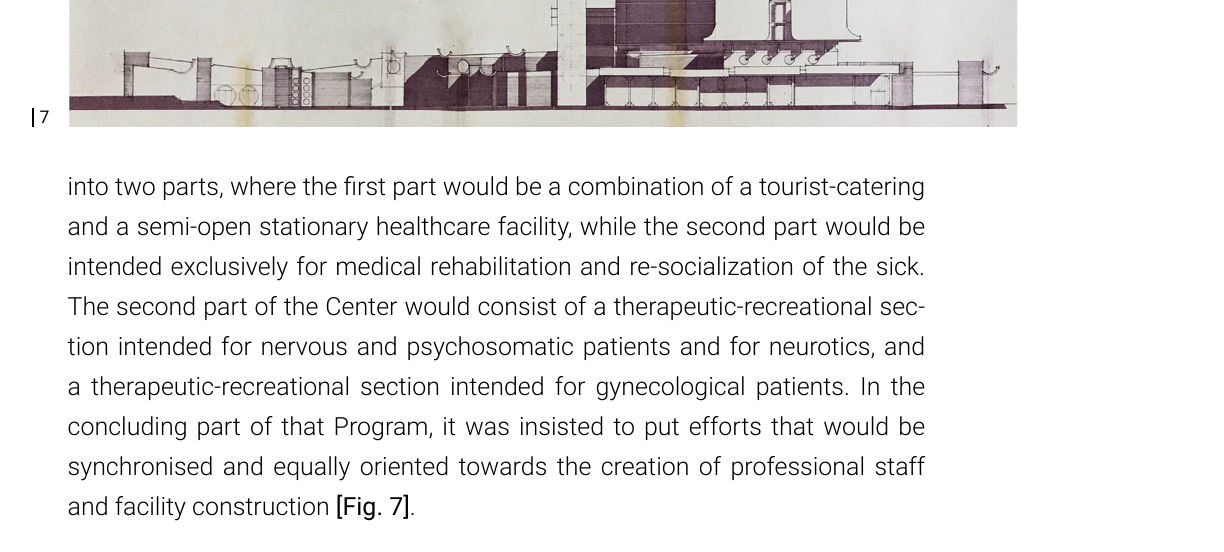
Fig. 7 Franc Avbelj et al., Project for Medical and Recreational Center H1 in Kuršumlija Spa (1973), Front (up), East (mid- dle) and West (bottom) facade (Source: Planika Company Archive in Kuršumlija,